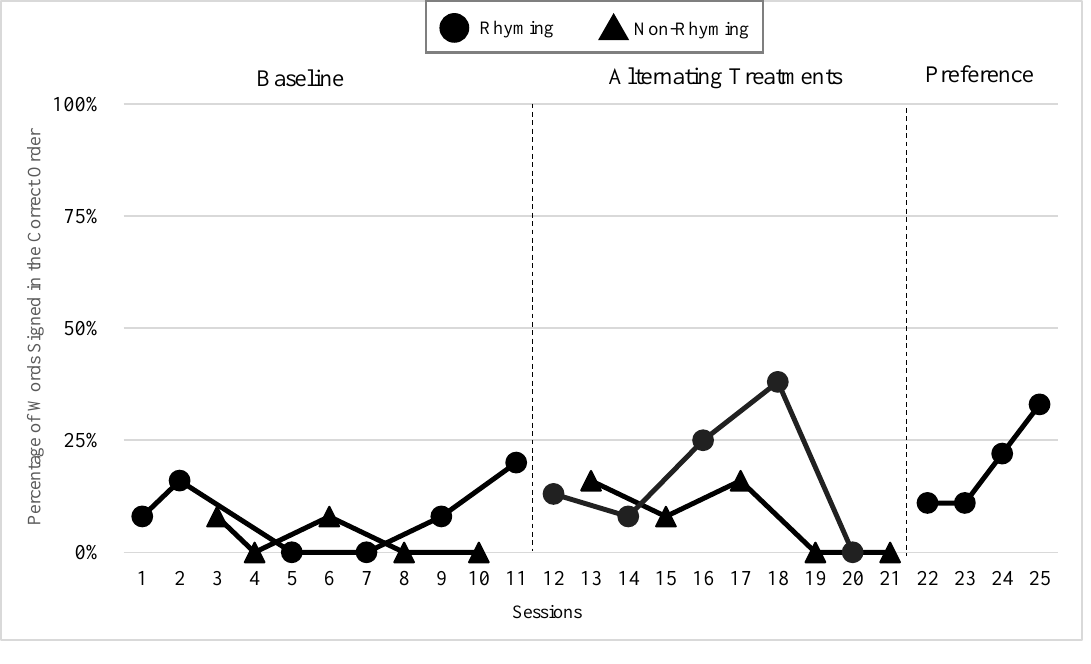
Figure 16. Lexie’s Percentage of Words Signed in the Correct Order in Recitation.